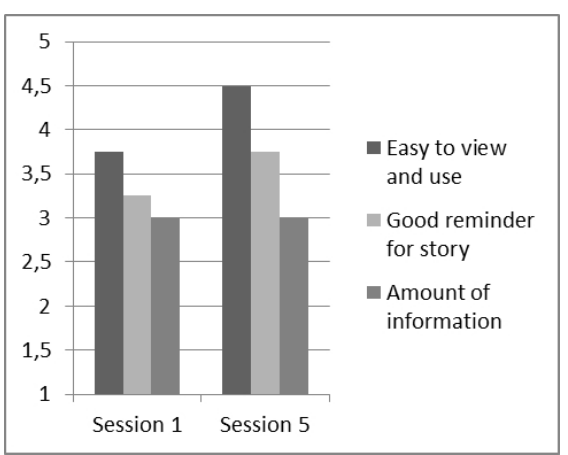
Figure 16. SuggestionsfeatureperceptionforAIBObehaviours(dataextracted from questionnaires).